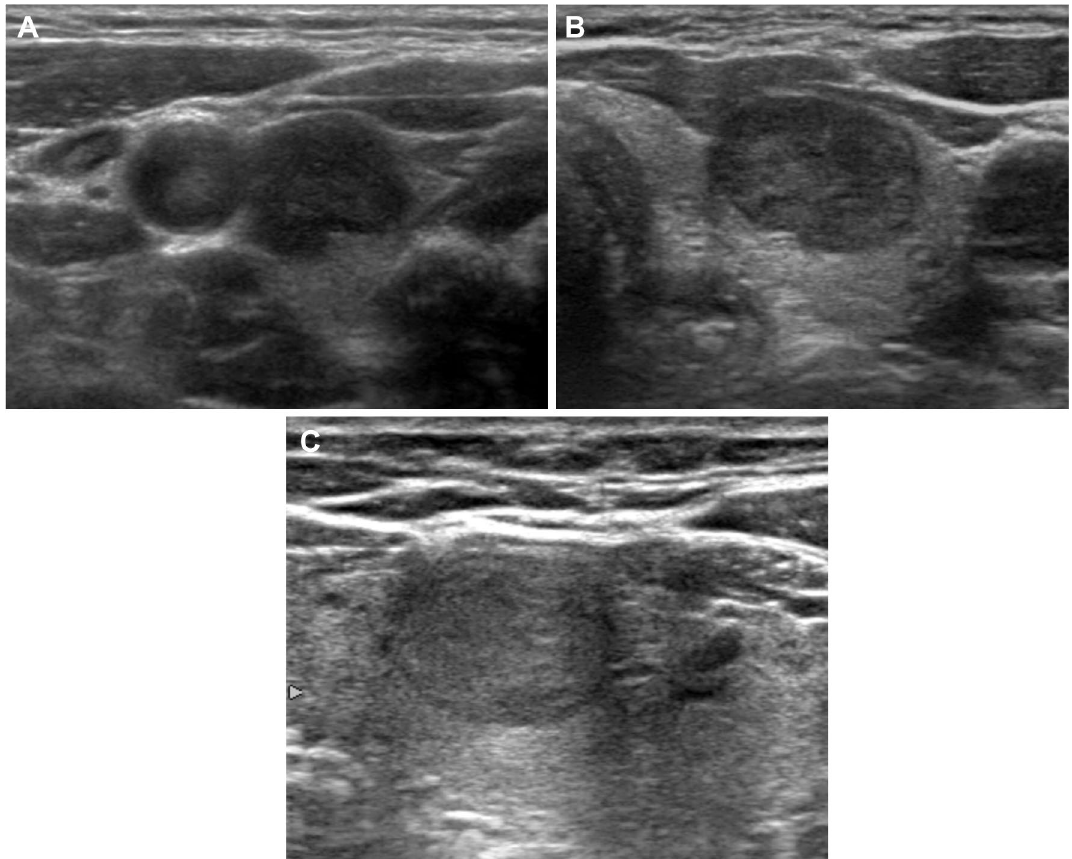
Figure 3. Hypoechoic thyroid nodules with various degree of hypoechogenicity. ( A ) Markedly hypoechoic nodule (hypoechoic relative to the anterior neck muscles) Diagnosis: Conventional papillary thyroid carcinoma ( B ) Moderately hypoechoic nodule (similar echogenicity to the anterior neck muscle). Diagnosis: Conventional papillary thyroid carcinoma ( C ) Mildly hypoechoic nodule (hypoechoic relative to the normal thyroid parenchyma, but hyperechoic relative to the anterior neck muscle). Diagnosis: Follicular variant papillary thyroid